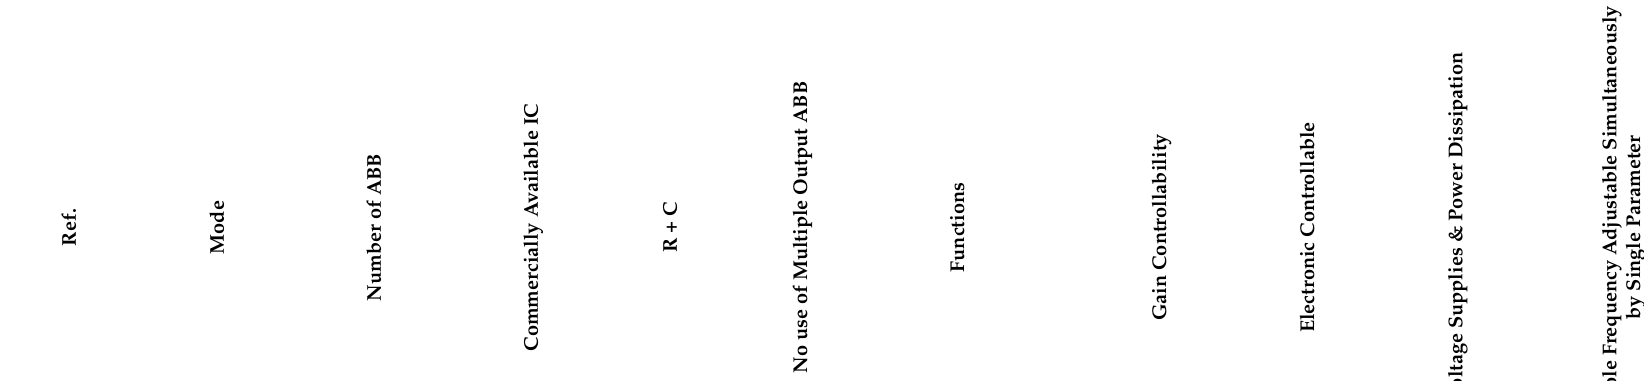
Table 1. Comparison of the proposed design with previous first-order multifunction